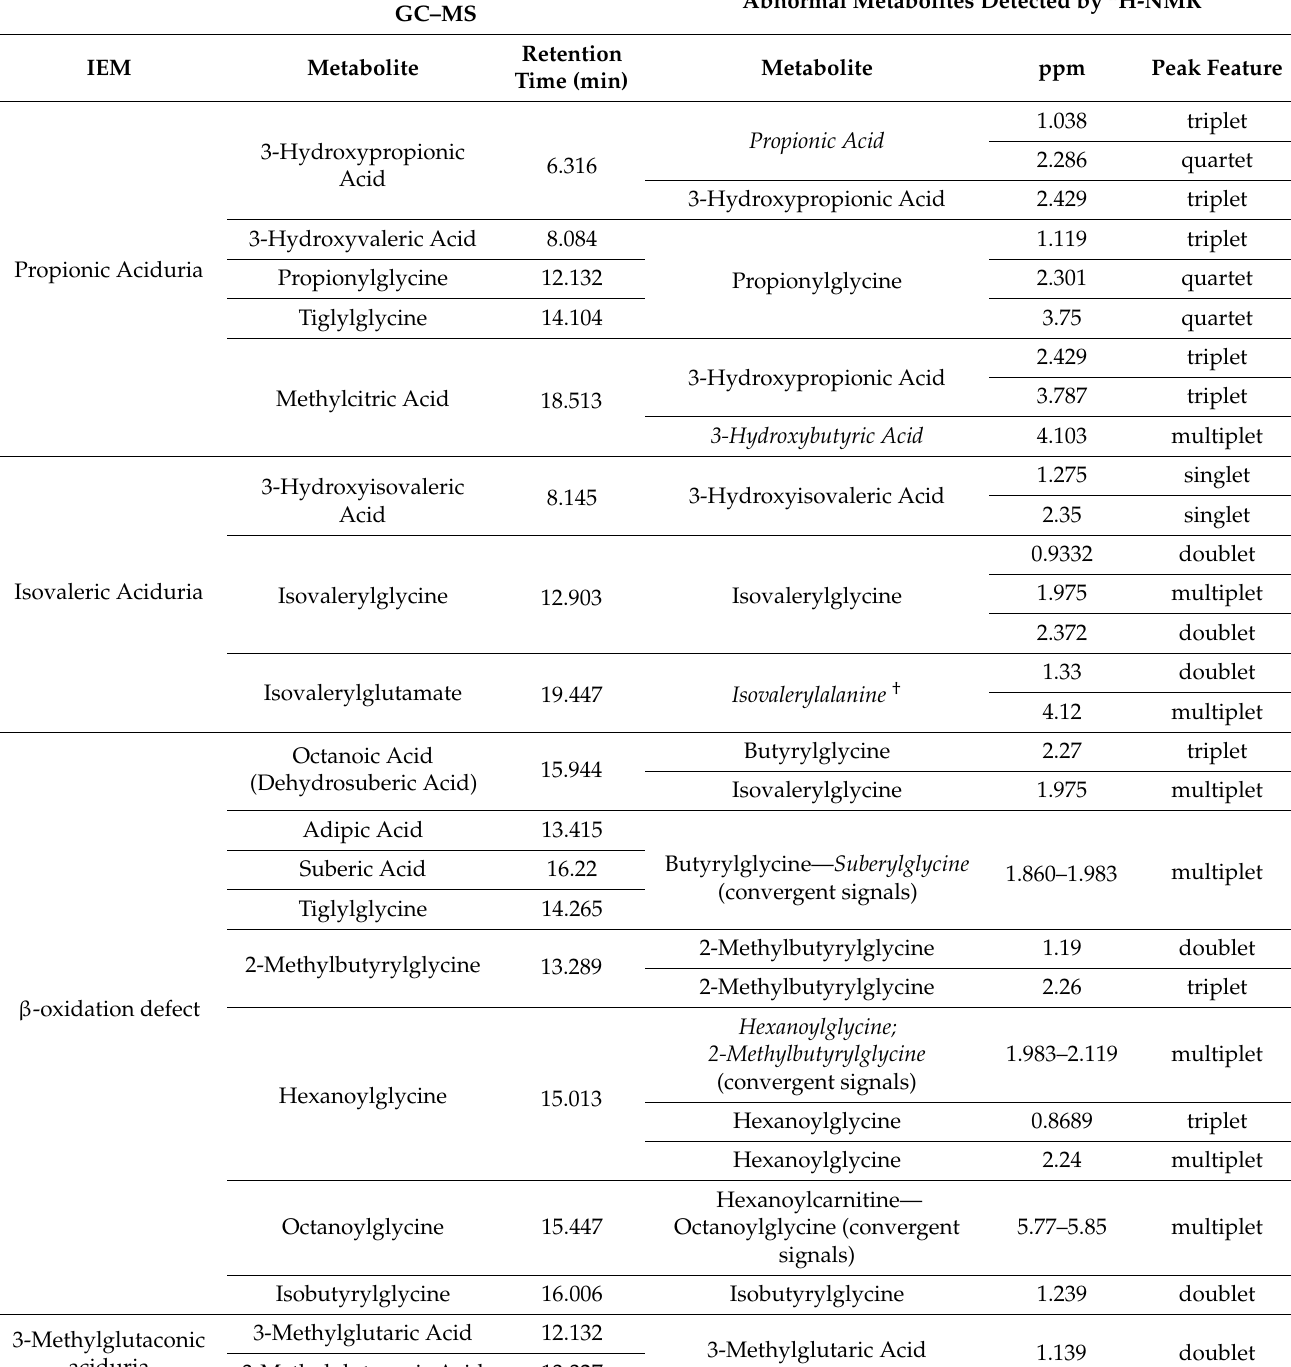
Table 1. Metabolites observed by GC–MS and 1 H-NMR. Metabolites in italics were only detected by 1 H-NMR. Represen- tative spectra of urine samples from respective individuals with certain IEM disorders are shown in the Supplementary Information